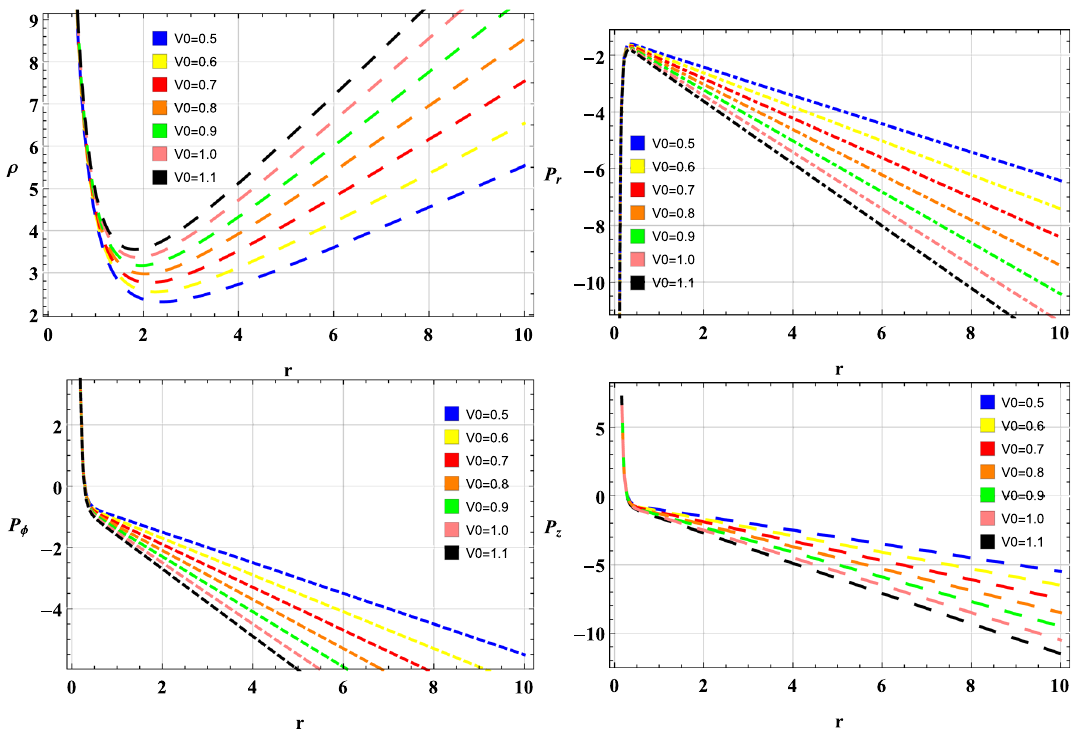
Fig. 1 The graphical behavior of energy density (MeV/fm 3 ) , p r (MeV/fm 3 ) , p φ (MeV/fm 3 ) and p z (MeV/fm 3 ) can be seen in this panel. CASE